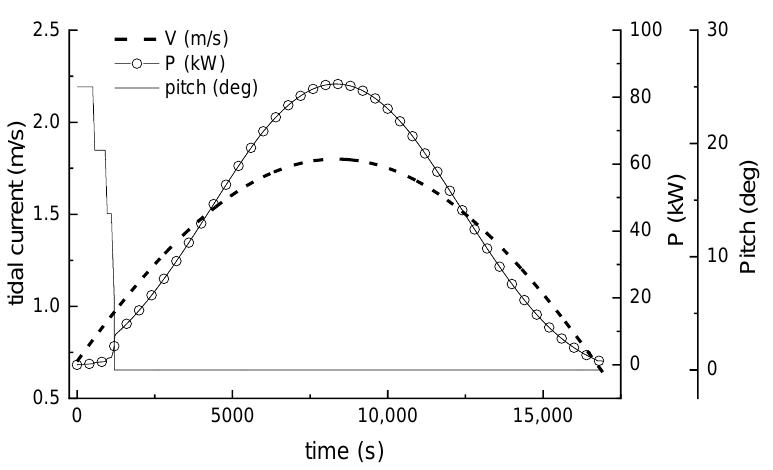
Figure 14. Simulation results of power generation when the maximum flow rate is 1.8 m/s.